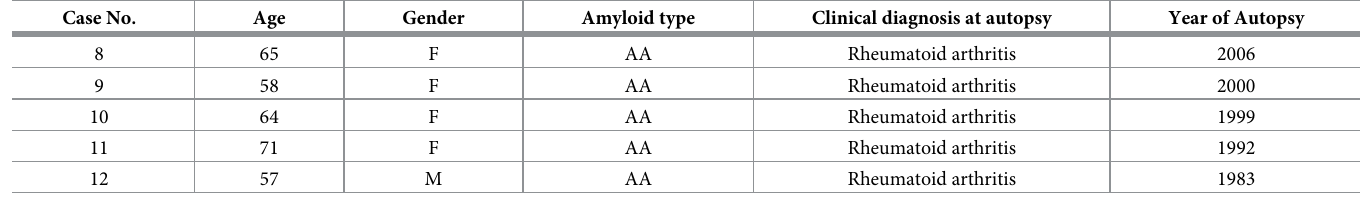
Table 3. Demographic features of patients with AA amyloidosis in another dataset obtained from different institutions. Case